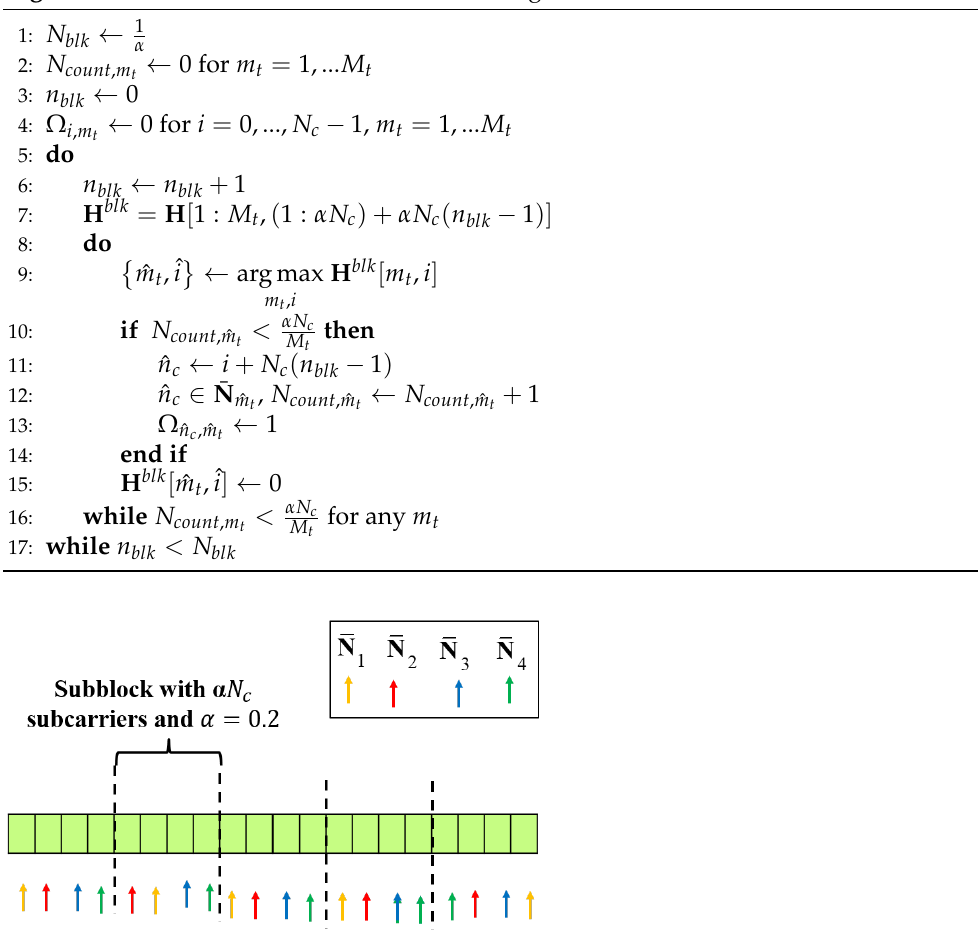
Algorithm 1 Subcarrier allocation method for a given α